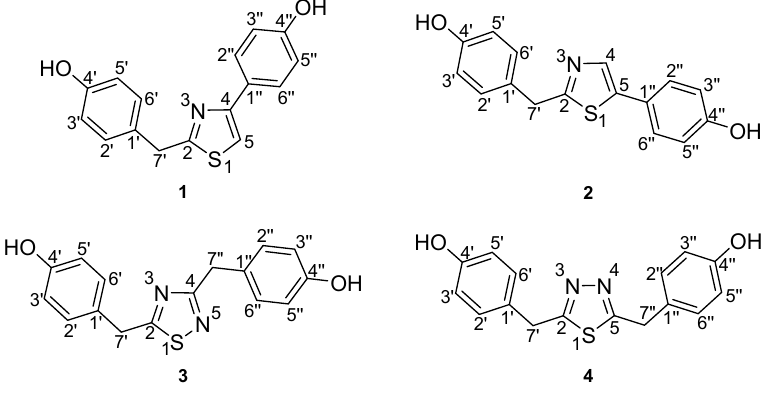
Figure 1. Chemical structures for the two pairs of isomers.